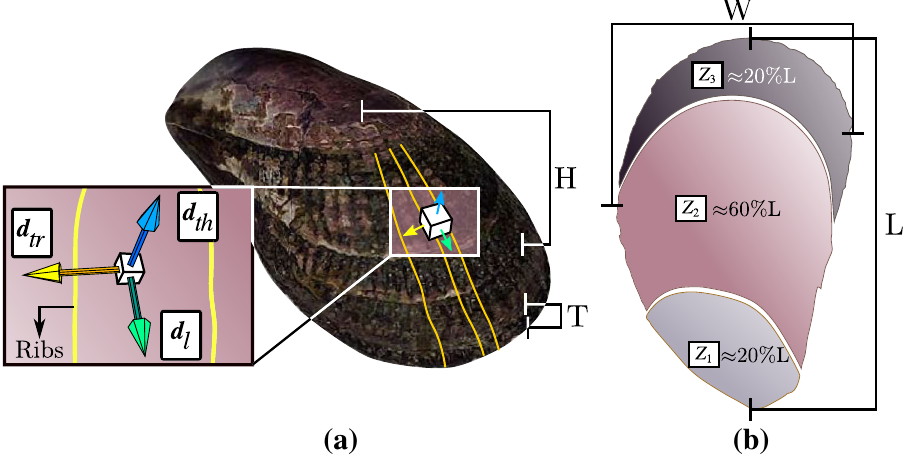
Figure 1. L : length, H : height, W : width, T : thickness. ( a ) Orthotropic directions of P. purpuratus shell material behavior: thickness direction ( ddd th ), longitudinal direction ( ddd l ) and transversal direction ( ddd tr ), ( b ) Zones in which the shell was divided, Zone 1 ( Z 1 ), Zone 2 ( Z 2 ) and Zone 3 ( Z 3 ). The respective percentage of the length is presented for each